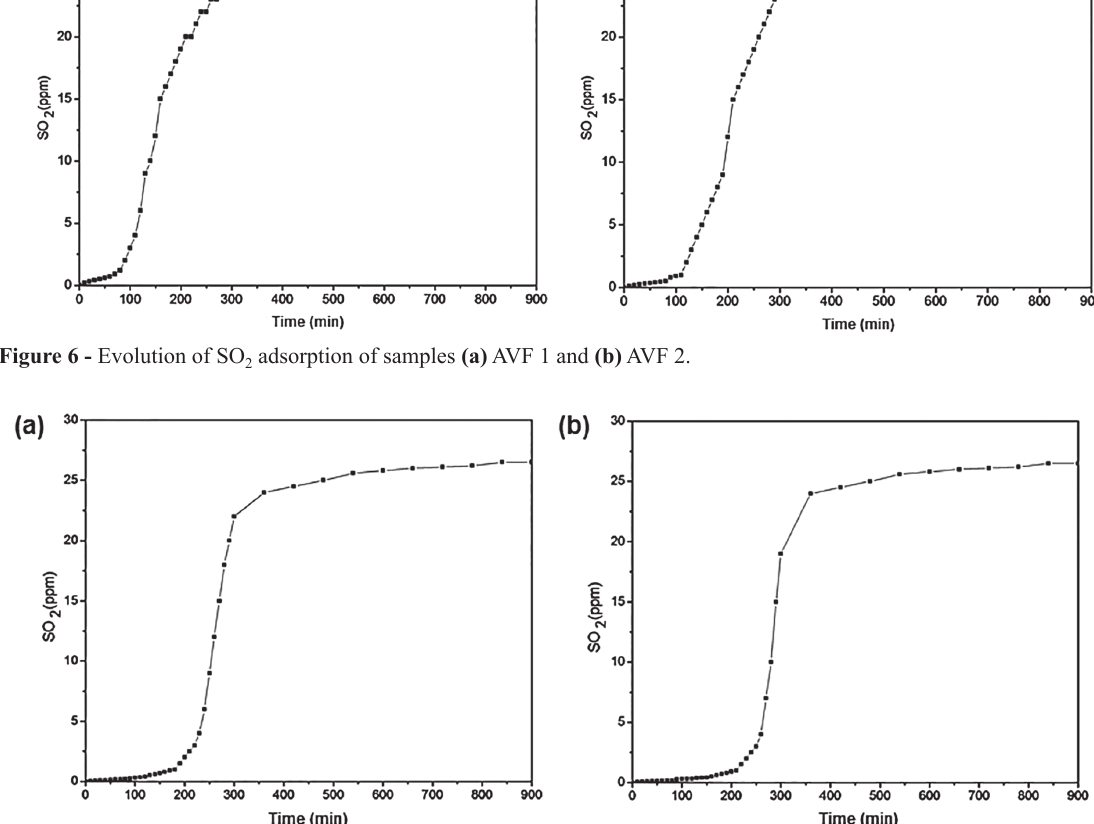
adsorption of samples (a) AVF 6 and (b) AVF 2